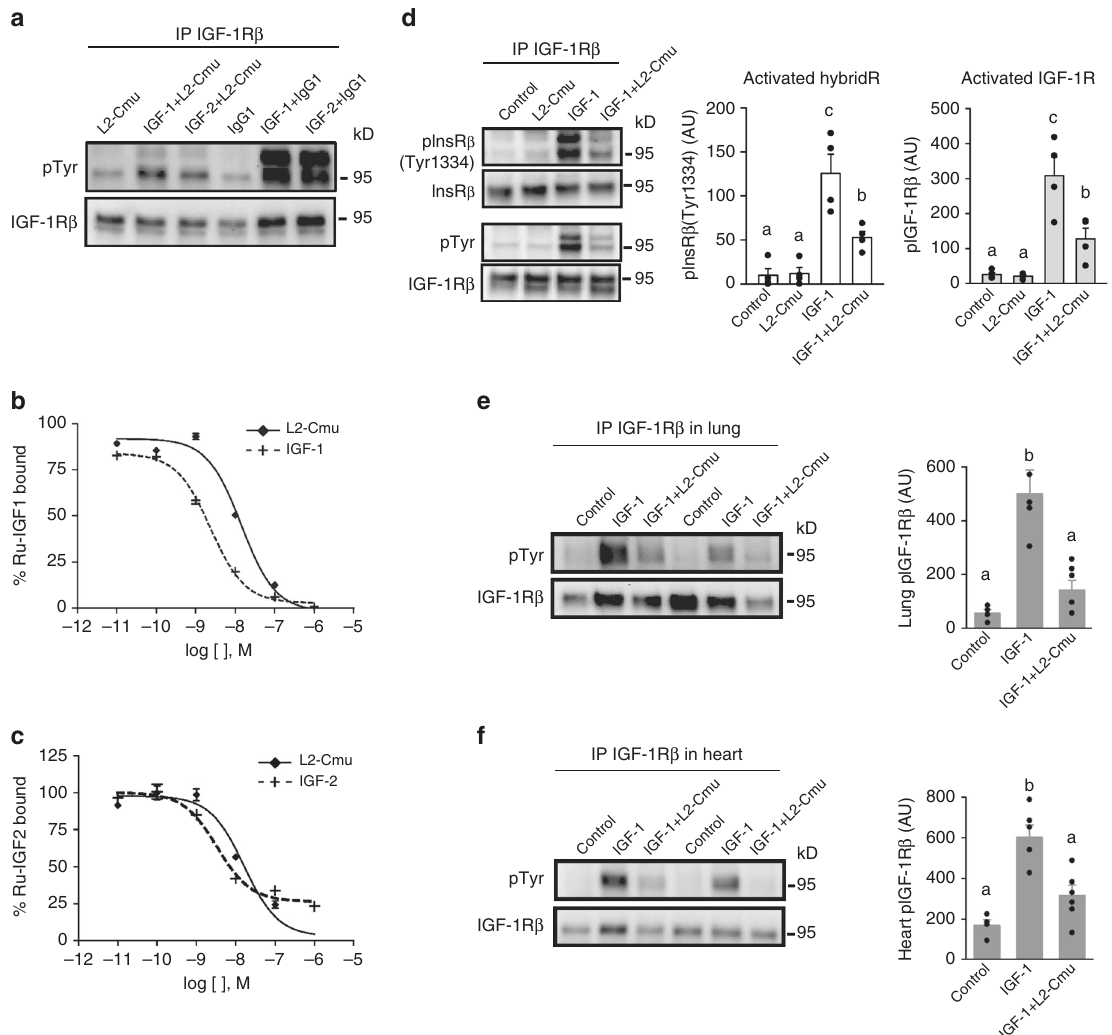
Fig. 1 L2-Cmu is an antagonist to the murine IGF-1R and hybrids. a NIH-3T3 cells were pre-treated with 100 μ g/mL Control IgG1 or L2-Cmu for 1 h prior to addition of vehicle, 5 nM IGF-1 or 20 nM IGF-2 for 2 min. Cell lysates were then immunoprecipitated for IGF-1R β and blots were probed for pTyr and total IGF-1R β levels. b , c Dose response competition assays with murine IGF-1R(ECD)-mFc. The ability of L2-Cmu to block human Ru-labeled IGF-1 or IGF-2 to the murine IGF-1R extracellular domain was evaluated in the IGEN format. d NIH-3T3 cells were pre-treated with vehicle or L2-Cmu (100 µ g/mL) 1 h prior to addition of media (Con), or IGF-1 (5 nM) for 2 min to assess activation of IGF-1R and IGF-1R/InsR Hybrids. Data show that L2-Cmu reduced activation of IGF-1Rs, HybridRs by ~65% as compared to IGF-1 alone ( n = 4 per condition). e , f For in vivo validation, mice were pre-treated with vehicle or L2-Cmu (20 mg/kg) i.p. and then challenged with an i.v. bolus of saline or 5 µ g IGF-1 to assess the ability of L2-Cmu to modulate IGF-1R activation in vivo for a total of three experimental groups: Control (vehicle + saline; n = 4), IGF-1 (vehicle + IGF-1; n = 5), and IGF-1 plus L2-Cmu ( n = 5 for lung and n = 6 for heart). L2- Cmu signi fi cantly inhibited IGF-1R activation in lung and heart. Bars represent mean ± s.e.m. Dot plots overlaid on bar graphs represent individual data points. Different letters denote a signi fi cant difference between treatments by Tukey HSD, P ≤